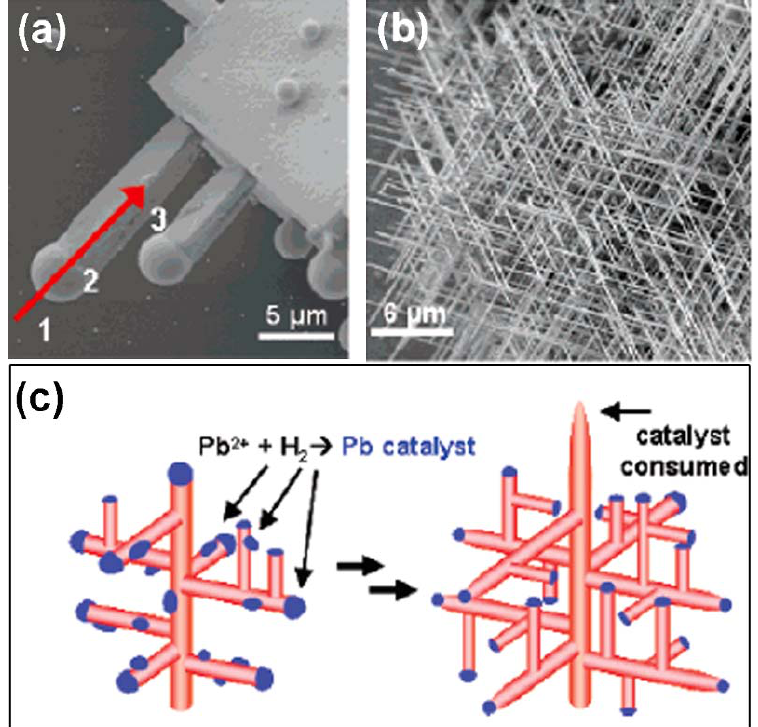
Figure 2. Hyperbranched PdSe nanowire network catalyzed by in situ generated Pb seeds. (a) An SEM image showing PbSe microrods with residual Pb catalyst caps. Chemical analysis along the red arrow confirmed the Pb/PbSe cap/nanowire composition. (b) An SEM image showing the 3D PdSe nanowire network. (c) A schematic illustration showing the in situ generation and consumption of the Pb catalysts during the growth. (Left) Pb 2+ was reduced to Pd catalysts that deposited on an existing network; (Right) New branches were grown from the catalysts, while an old branch (marked by the arrow) stopped to grow when the catalyst was completely consumed (reproduced with permission from American Chemical Society